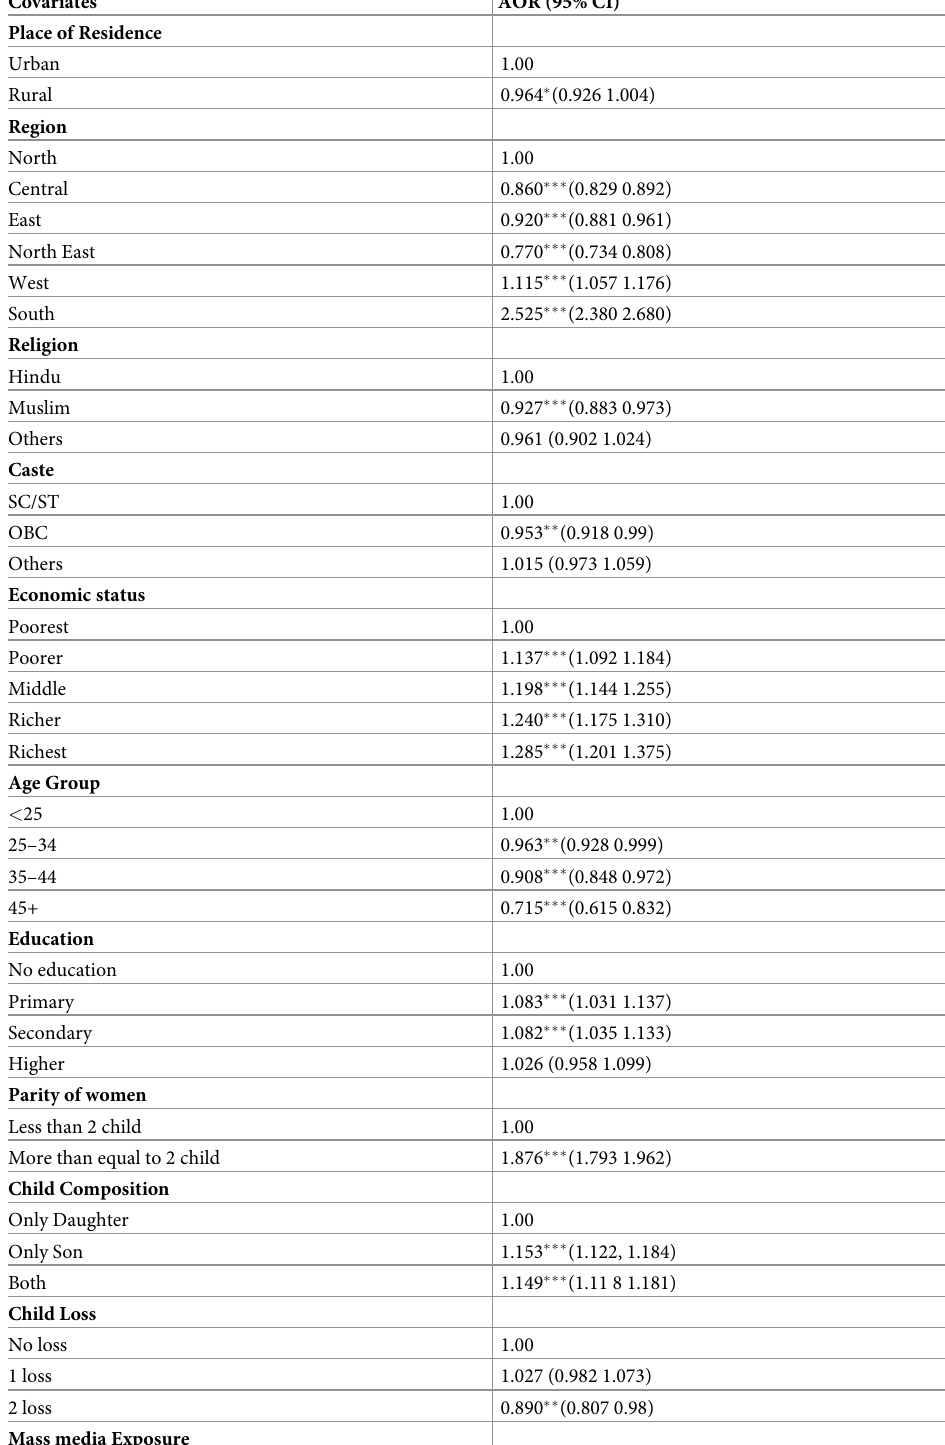
Table 4. Discrete time complementary log -log model results on modern contraceptive adoption by selected covariates, NFHS,